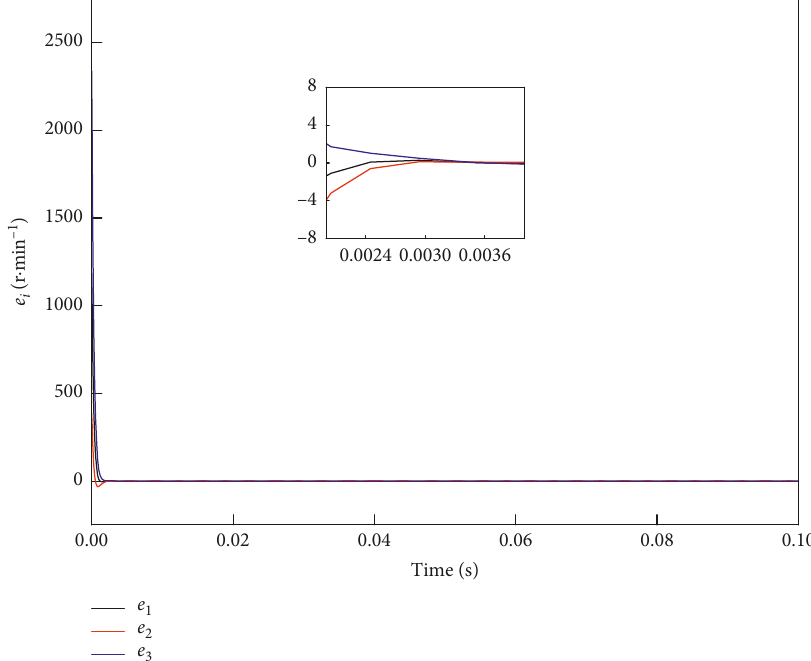
Figure 9: The error curves of the single axis system under the sliding mode variable control.